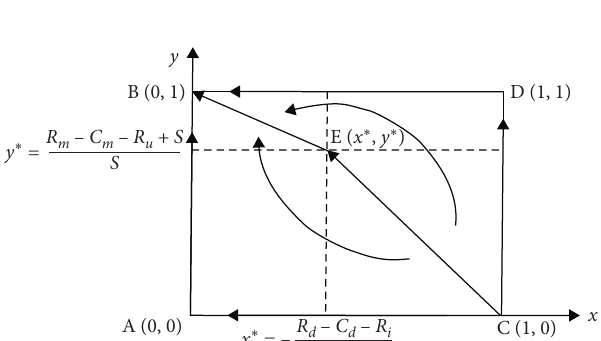
Figure 5: The replication dynamic phase map for scenarios (6), (7), (12), and (13).